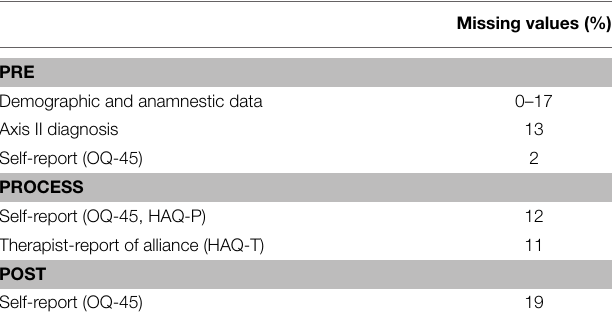
TABLE 2 | Amount of missing values in the analysis sample ( n = 260